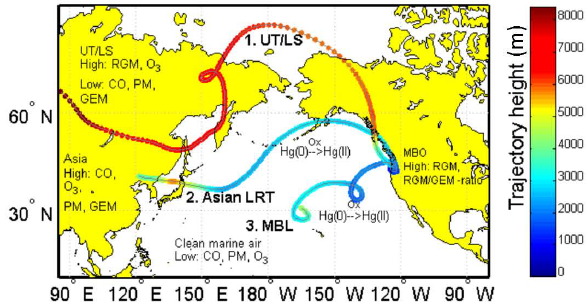
Fig. 1. Sources of RGM in the free troposphere as measured at MBO: 1, UT/LS (Swartzendruber et al., 2006; Ambrose et al., 2011); 2, ALRT (this paper); and 3, clean marine boundary layer (MBL) air masses processed in the FT above the Pacific Ocean (this paper). The HYSPLIT airmass back trajectories of three events (UT/LS: 22 April 2006; ALRT: 17 April 2008; MBL: 9 May 2007) are used to show a typical pathway of airmasses during each event type. Trajectories are colored by height. The typical chemical com- position of airmasses (ozone (O 3 ) , CO, and particulate matter (PM) concentrations) are shown for the areas where the trajectories orig- inate. Key features of the Hg observations at MBO are also